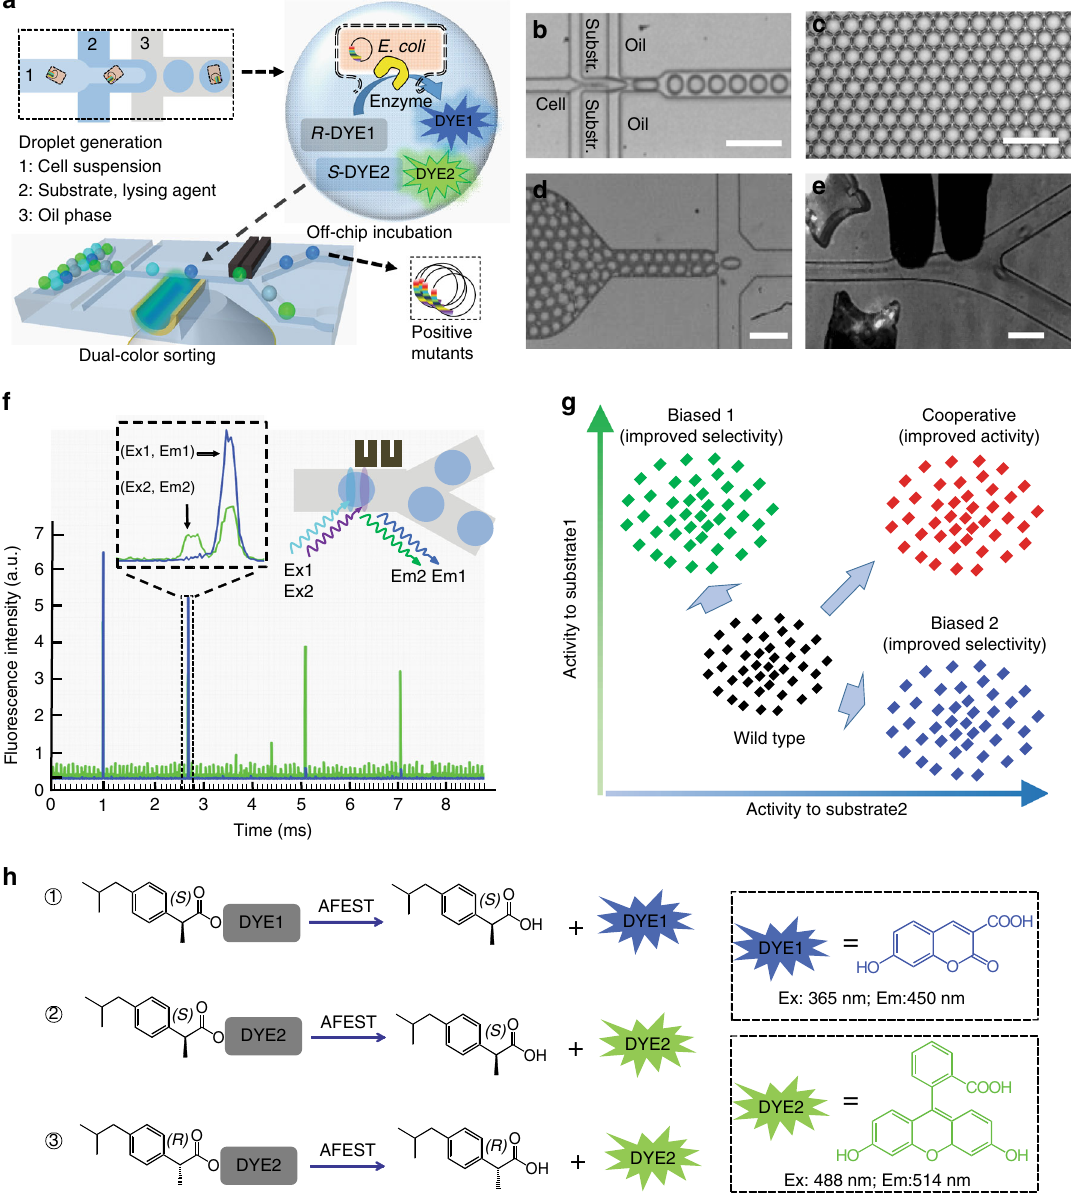
Fig. 1 DMDS platform for screening enzymatic enantioselectivity. a Schematic of DMDS operation. Mutant enzyme-expressing single cells are encapsulated in water-in-oil droplets with two fl uorogenic substrates and lysis buffer. After the droplets are incubated for a speci fi ed time, those droplets containing the desired mutants are enriched via fl uorescence-activated droplet sorting. Optical images of DMDS processes: b droplet generation; c off-chip incubation; d droplet reinjection; e fl uorescence-activated droplet sorting. f To avoid crosstalk of two fl uorescence signals, the droplets are excited by two spatially separated lasers, which generates two temporally separated emissions. g Sorting different populations in a mutation library with the DMDS platform is achieved via two screening modes: a cooperative mode and biased modes. h Three fl uorogenic substrate designs and their enzymatic reactions yielding two different fl uorescence signals. Scale bars: 100 μ